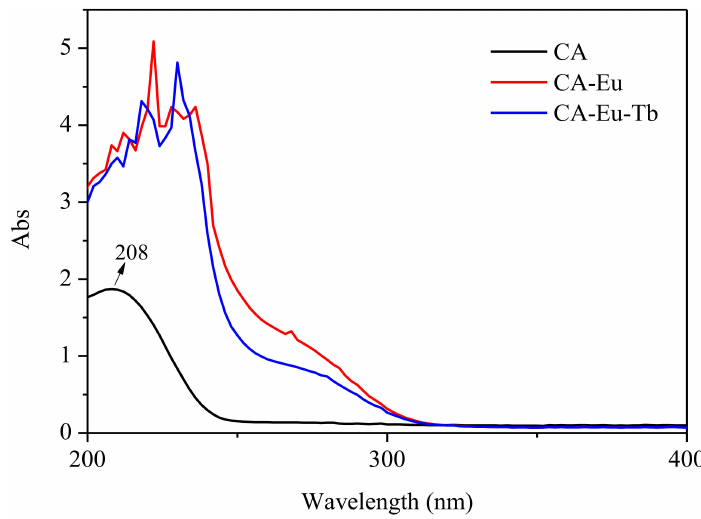
Figure 5. UV absorption spectra of CA, CA-Eu and CA-Eu-Tb